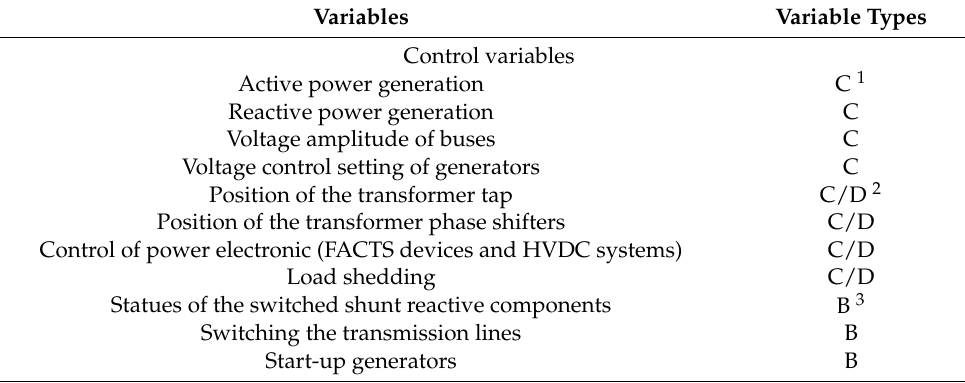
Table 1. Classification of OPF and ORPD